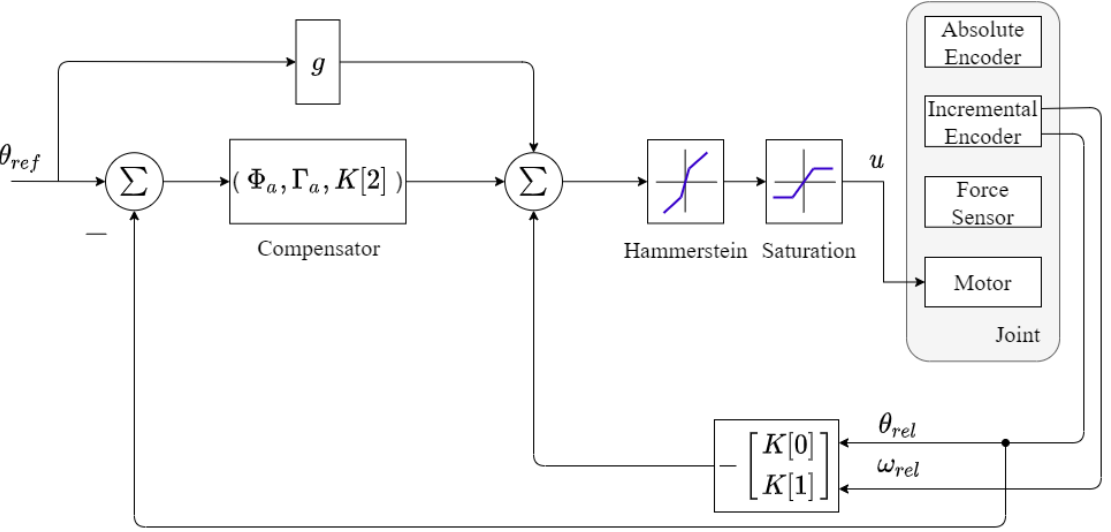
Figure 12. State-space controller block diagram rigid